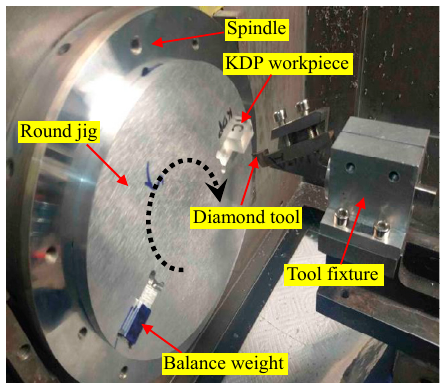
Figure 6. Schematic diagram for the tool-edge passivation method at different depression angles, i.e., 0°, 45°, and 60°.